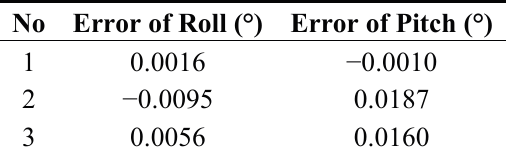
Table 2. Level attitude errors of wobbling